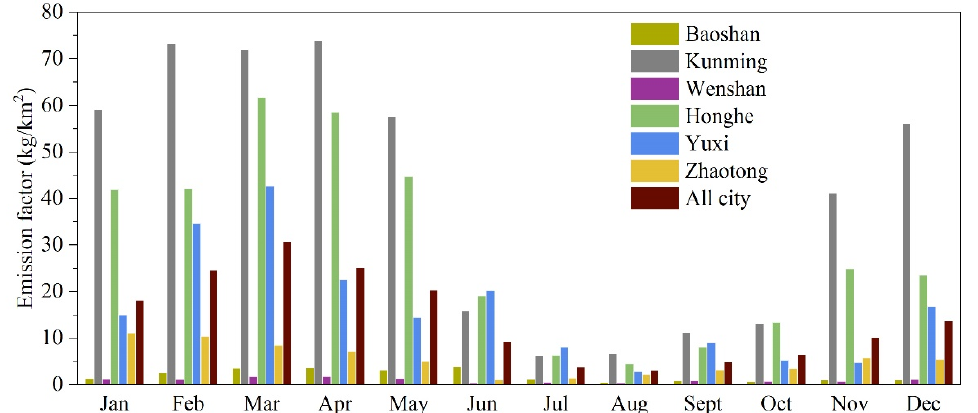
Figure 6. Monthly emission factor of PM 2.5 of soil fugitive dust.